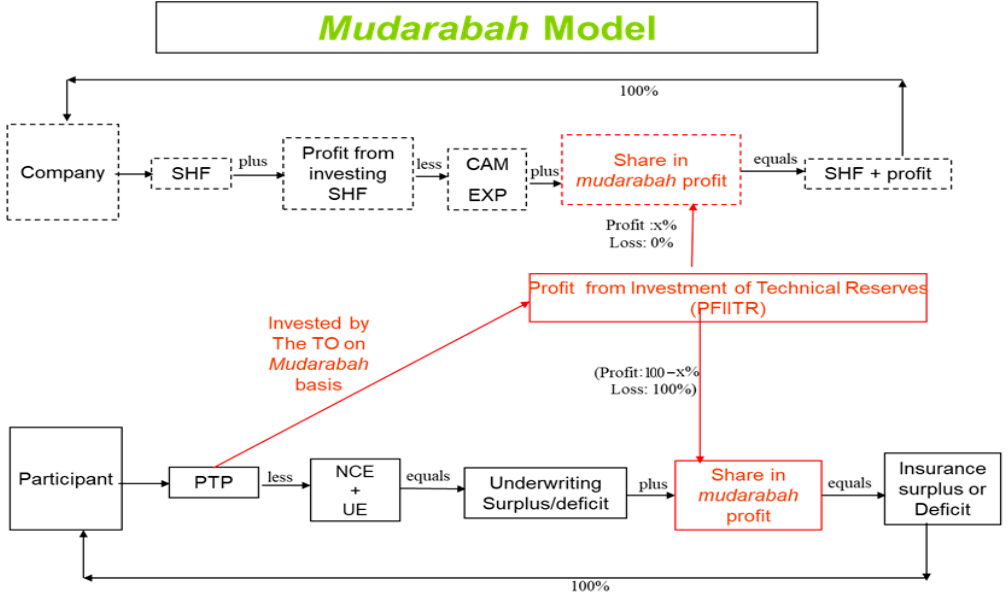
Figure 1. Mudarabah -based operational model of takaful. Note: SHF = Shareholders fund; CAM EXP = Company’s Admiration and Management Expenses; PTP = Participant Takaful Pool; NCE = Net Claim Expenses; and UE = Underwriting Expenses.